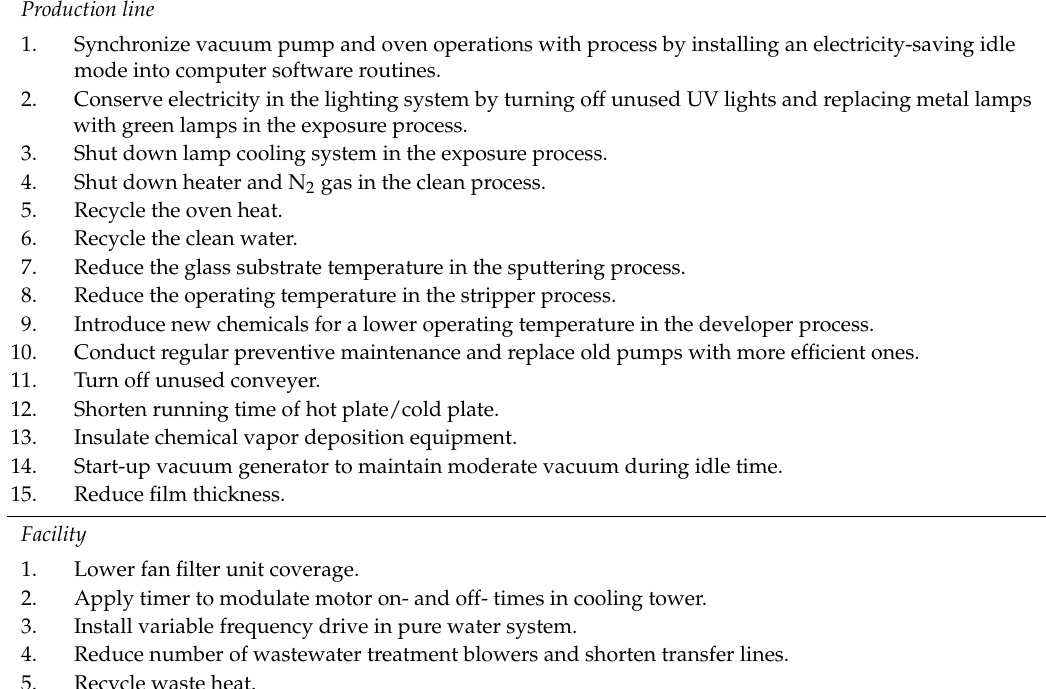
Table 2. Proposed strategies for energy